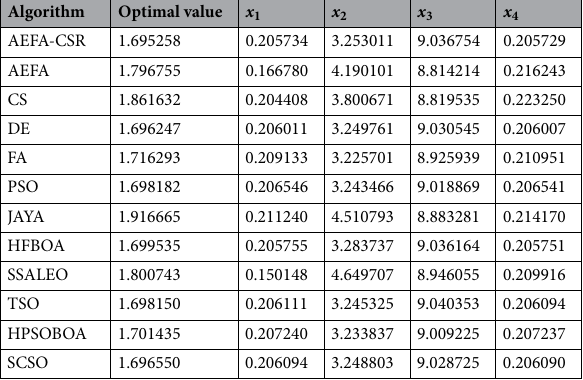
Table 15. Welded beam design problem.